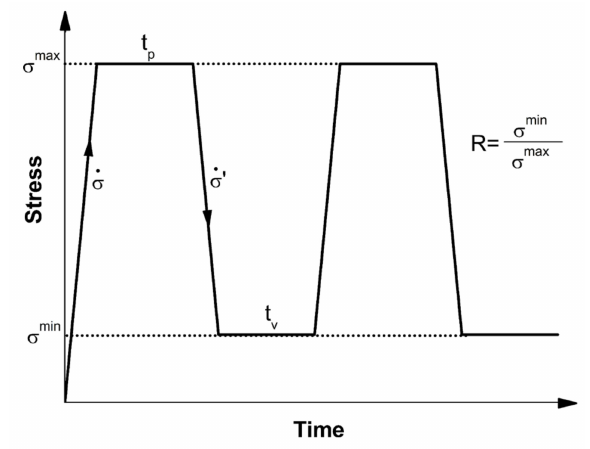
Figure 2. Pulsating wave under stress